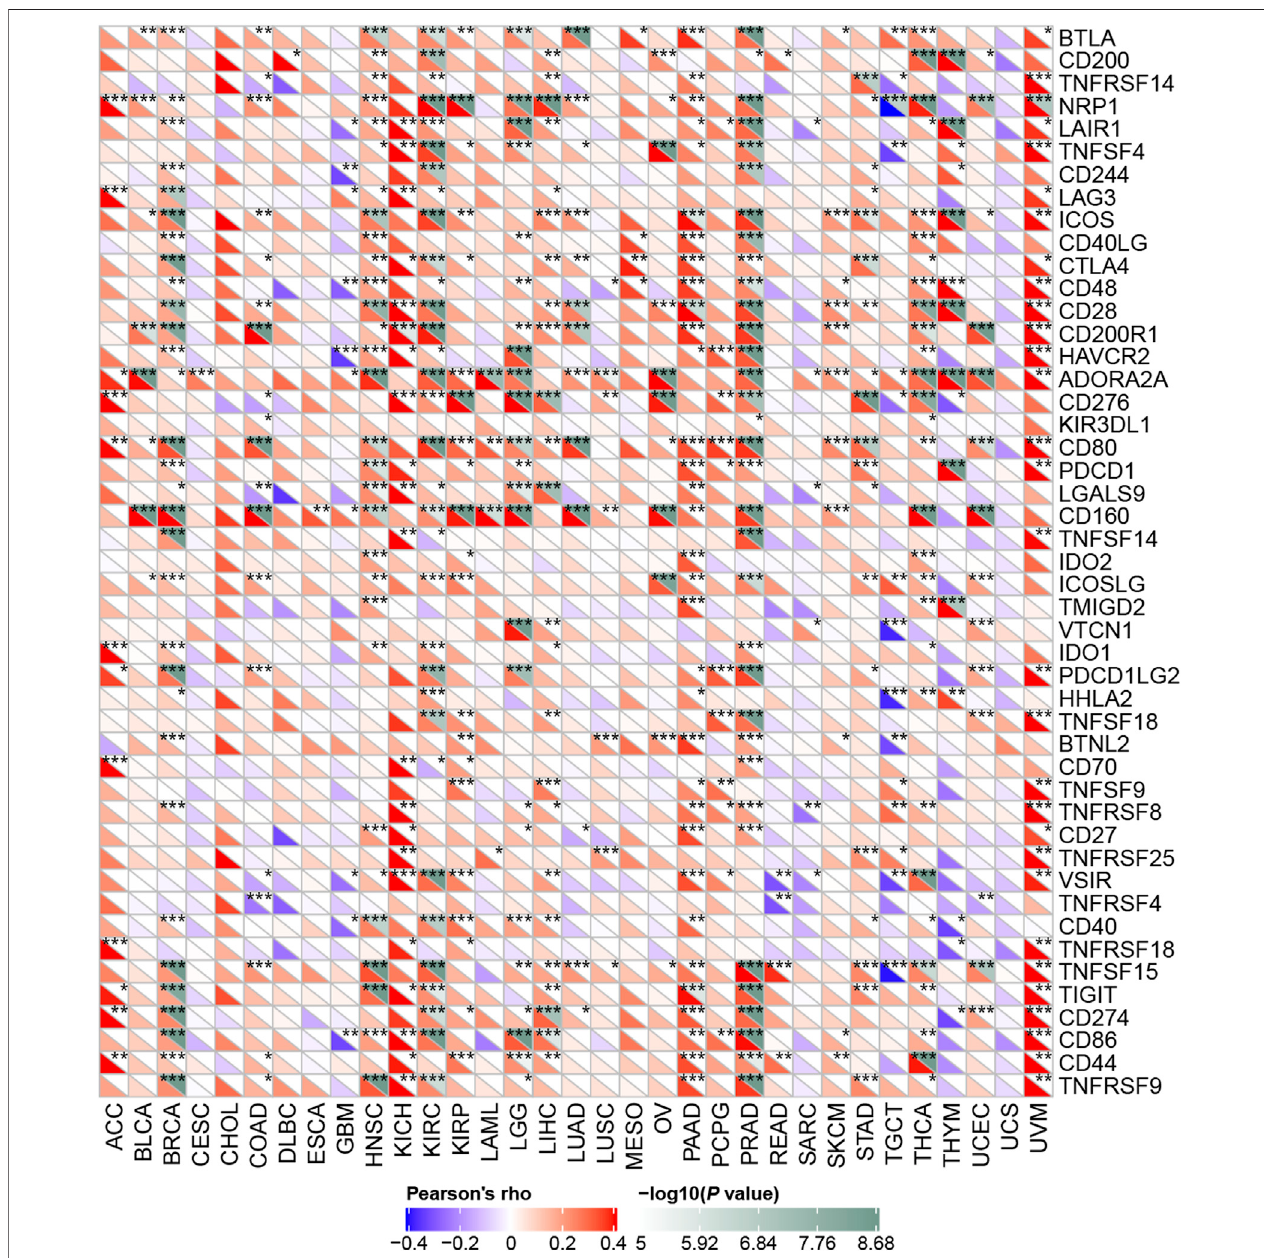
FIGURE 8 | Correlation analysis of RBM15 expression levels with 47 immune checkpoints in human pan-cancer. * p < 0.05, ** p < 0.01, *** p < 0.001.